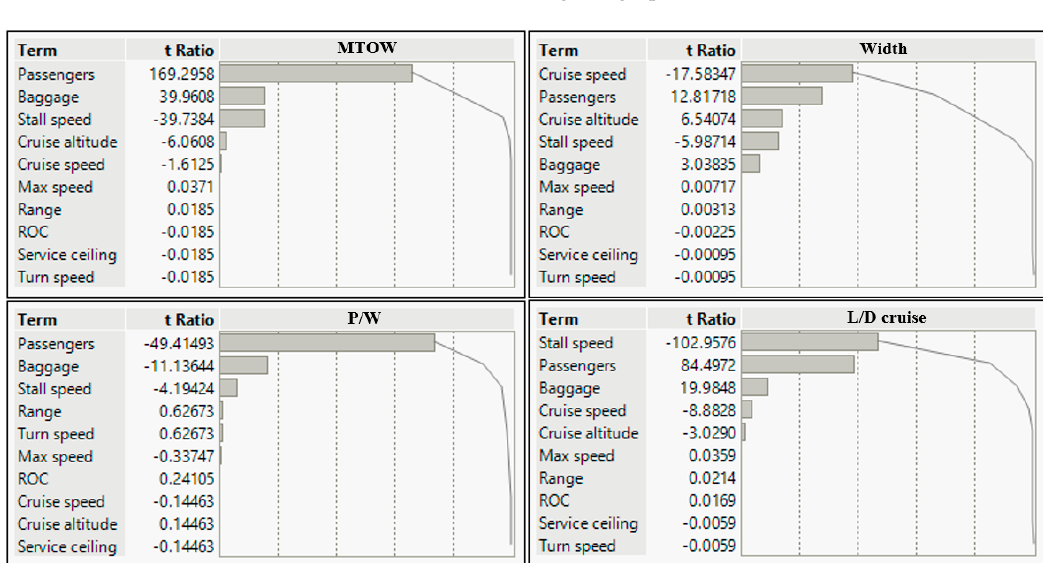
Figure 12. Screening test graph. Appl. Sci. 2020 , 10 , 5112